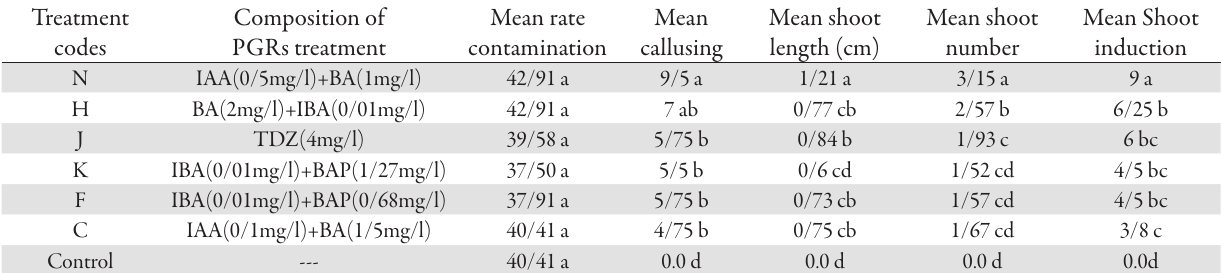
Tab. 3. Effect of different PGRs treatment on shoot proliferation